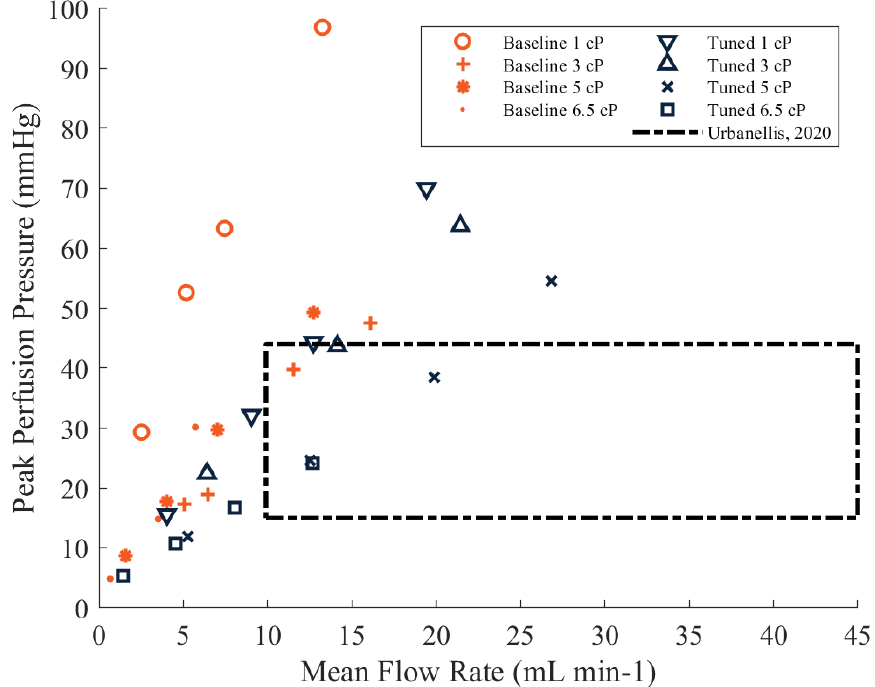
Figure 5. Peak Perfusion Pressure and Mean Flow Rate produced by VOPS (vascular resistance of 0.22 mmHg/mL/min). Box represents the range of values utilized in previous preservation studies [50]. Tuning the pulse frequencies and duty cycles used in the VOPS experimentation tended to decrease the peak perfusion pressures and increase the mean flow rates. At a viscosity of 1 cP, mean flow rates ranged from 4.0 ± 0.11 to 19.4 ± 0.42 mL/min and peak perfusion pressures ranged between 15.5 ± 1.06 to 70.0 ± 4.89 mmHg. A viscosity of 3 cP used in the VOPS device produced mean flow rates between 6.4 ± 0.06 and 28.2 ± 0.26 mL/min alongside a range of peak perfusion pressures between 22.4 ± 1.19 to 83.8 ± 1.05 mmHg. The VOPS device, at a viscosity of 5 cP, produced mean flow rates between 5.2 ± 0.07 and 26.8 ± 0.24 mL/min and peak perfusion pressures between 11.8±0.96 and 54.5±1.17 mmHg.